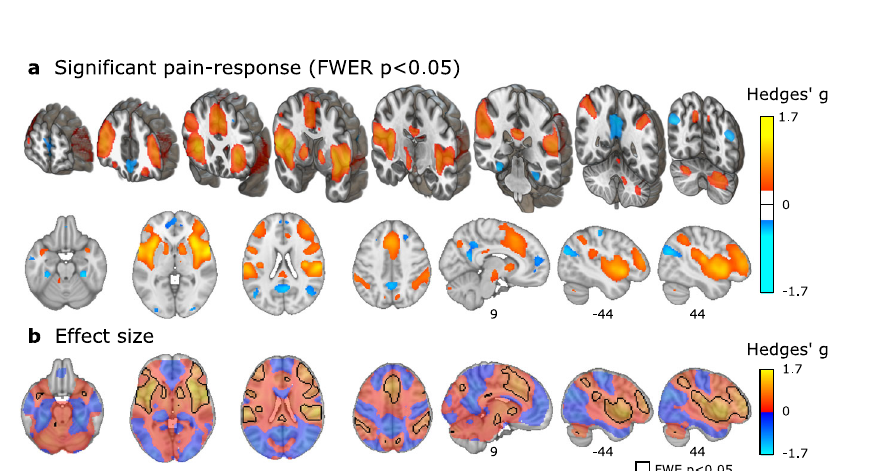
Fig. 1 Pain-related activity in experimental placebo imaging studies. a Statistically signi fi cant pain-responses (permutation test, controlled for FWER, two-sided p < 0.05), and b whole-brain unthresholded standardized effect size g , of acute pain stimulation > baseline, pooled across placebo and control conditions (FWER-corrected permutation test results are delineated as a back contour); range g : [ − 0.82, 1.68]; all: n = 543 – 603 individuals from 17 to 20 independent studies per voxel. Three-dimensional coronal slices are equidistantly distributed from y = 60 to − 68 mm. Axial slices range equidistantly from z = − 22 to 42 mm. Custom coordinates for sagittal slices are displayed in mm. Source data (results as 3d-volumes) are provided at